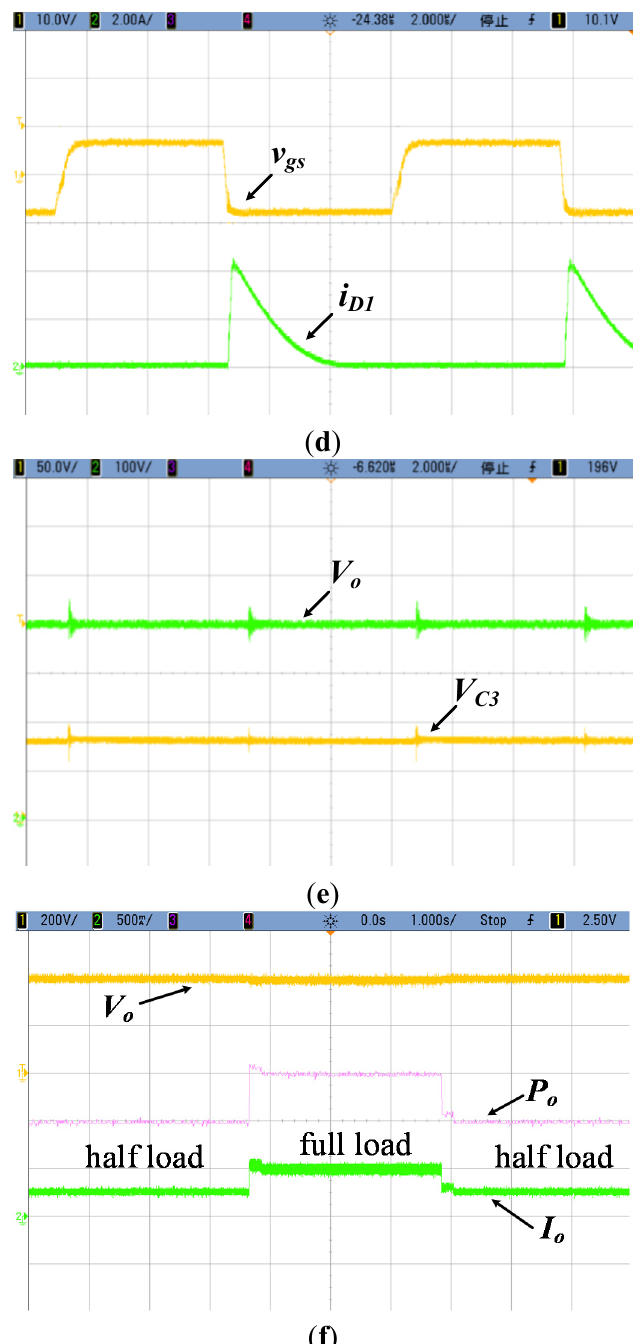
Figure 9. Experimental results at 200 W: ( a ) Power switch voltage